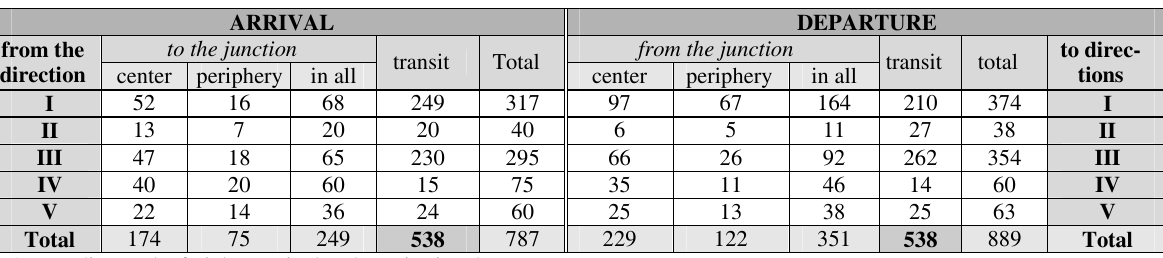
Table 2. Arrival–departure of freights and road trains through transport hub (N. Novgorod) a – Freights arrival–departure (in thousand tons,